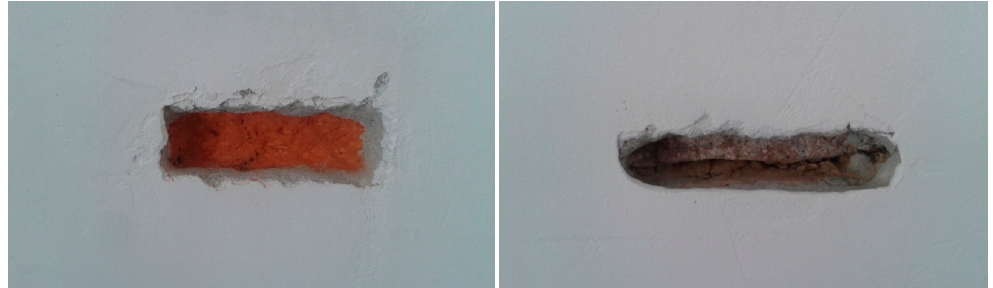
Figure 2. Opencasts in the masonry wall at the places of brick and joint. Sampling places for research studies.